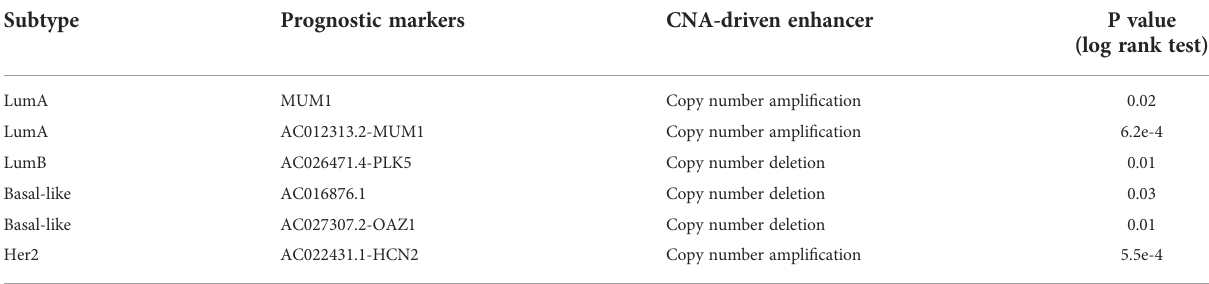
TABLE 1 Targets of CNA-driven enhancers and lncRNA-mRNA pairs as subtype-speci fi c prognostic markers.